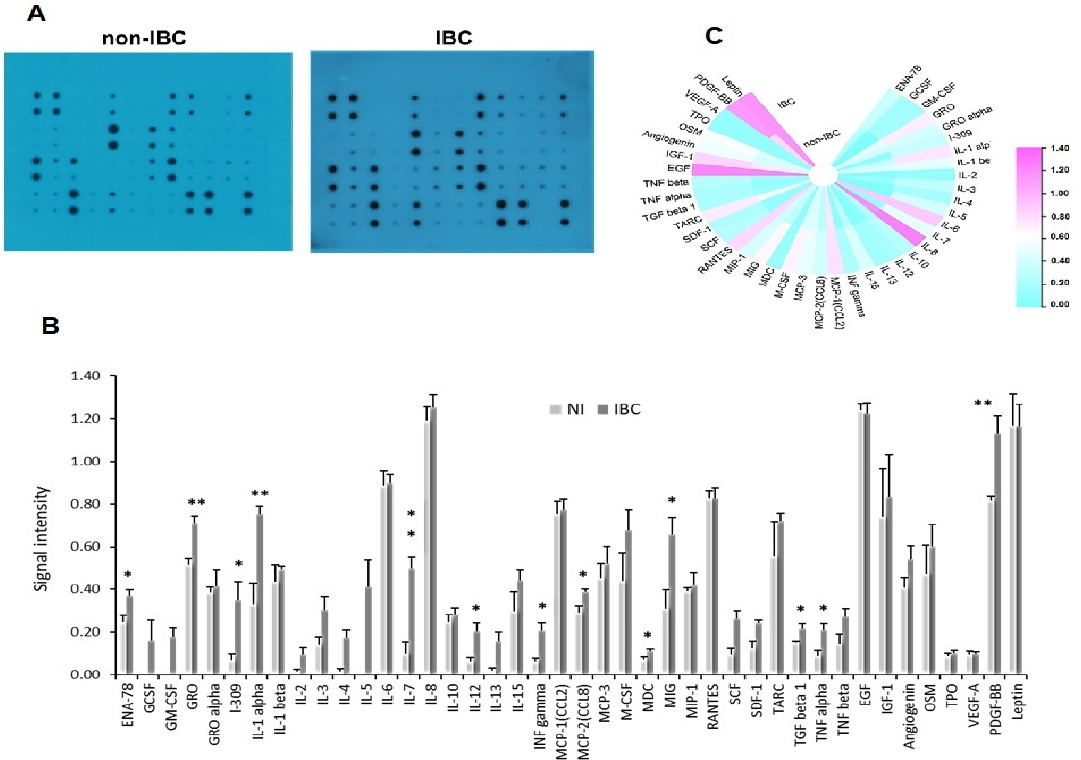
Figure 1. Human cytokine array for WF collected from IBC and non-IBC patients. Cytokine profile of WF collected from non-IBC and IBC breast cancer patients. ( A ) X-rays represent Human Cytokine Antibody Array™, which assessed 42 cytokines, chemokines and growth factors. Dots represent the intensity value of antibodies for specific WF cytokine (antigen). ( B ) Bars indicate the mean ± SEM of the signal intensity of each cytokine released in WF of non-IBC ( n = 11) and IBC ( n = 11) measured using ImageJ software. * represents significant p < 0.05, ** represents significant p < 0.01 as determined by Student’s t -test. ( C ) LogFC heatmap of the image data of cytokine array expression of the proteomic composition of wound fluid of both non-IBC and IBC, which revealed 42 distinct cytokines, chemokines, and growth factors; highly expressed cytokines are displayed as shades of pink and minimally expressed cytokines are shown as shades of